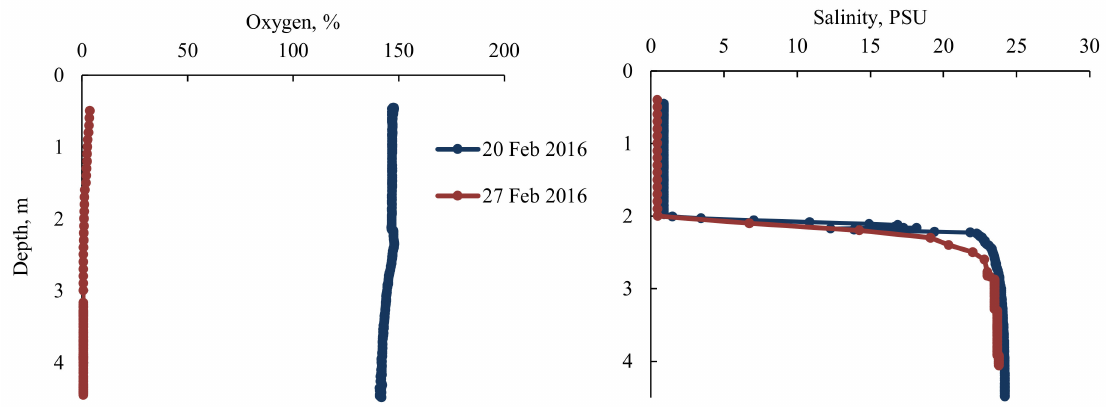
Figure 7. Vertical distribution of DO and salinity before (20 Feb. 2016) and after (27 Feb. 2016) snowfall at St. 5.